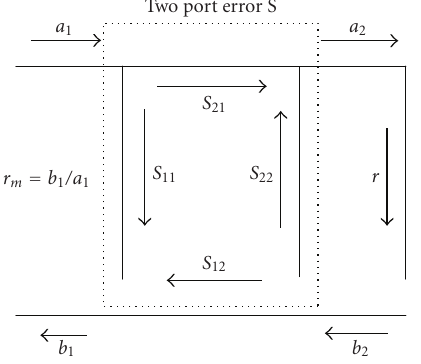
Figure 4: Error-term flow graph for one port vector network analyzer; a and b are reflected